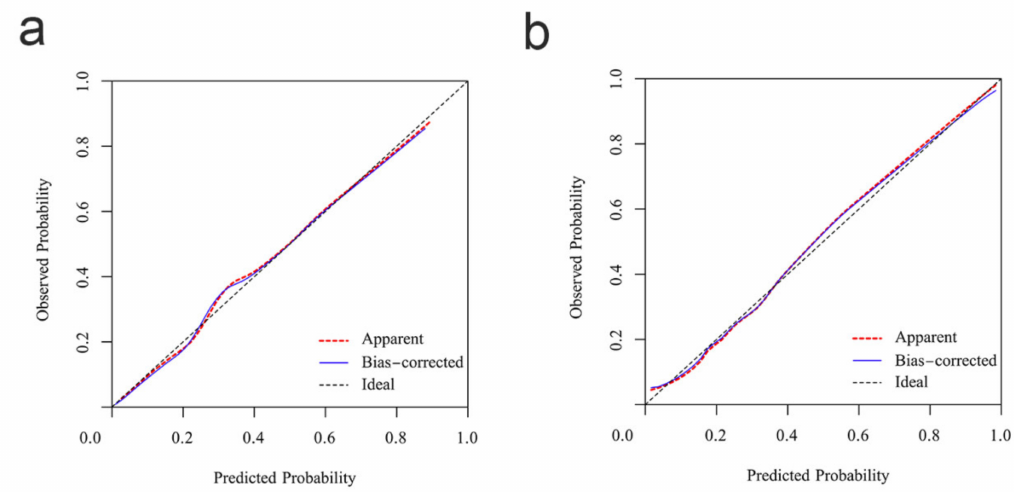
Figure 3. The calibration curves for the nomogram of the training group and the validation group. The black dashed line is the reference line for where an ideal nomogram would lie. The red dotted line is the performance of the nomogram and the blue solid line corrects for any bias in the nomogram. ( a ) The training group; ( b ) the validation